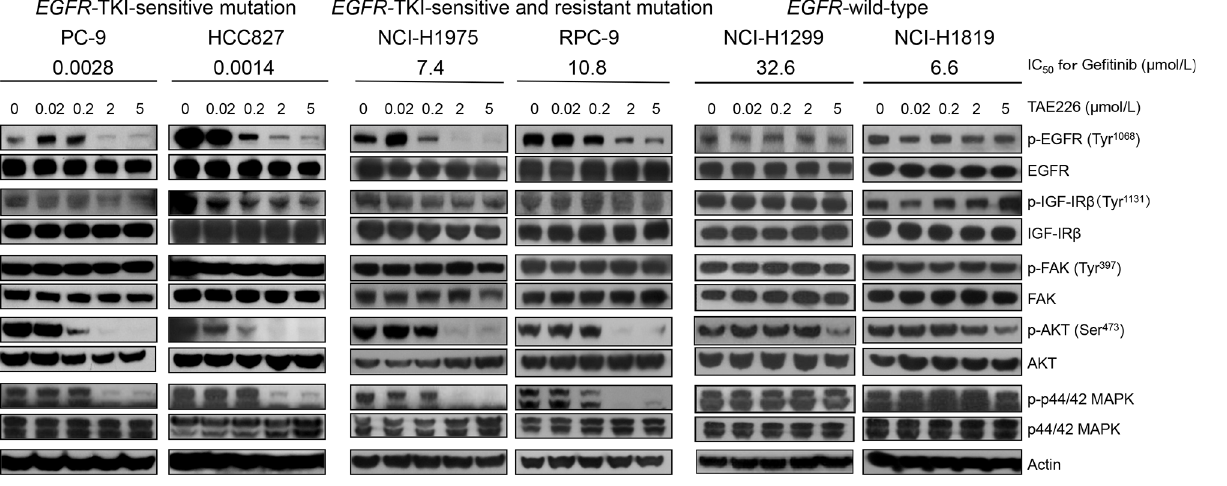
Fig 1. The effects of TAE226 on EGFR-related pathways in NSCLC cell lines. The NSCLC cell lines with EGFR-TKI-sensitive (exon 19 deletions) mutation (PC-9 and HCC827), cell lines with both EGFR-TKI-sensitive and-resistant (T790M) mutations (NCI-H1975 and RPC-9), and cell lines with wild- type EGFR (NCI-H1299 and NCI-H1819) were treated with TAE226 at several concentrations and western blotting analysis was performed. The phosphorylations of FAK and IGF-IR were not suppressed in all NSCLC cell lines tested. In contrast, the phosphorylations of EGFR and its downstream proteins, AKT and MAPK, were suppressed at lower concentration of TAE226 in EGFR -mutant cell lines regardless of the presence of T790M mutation compared with EGFR -wild-type cell lines. We incubated the membrane for Actin (42 KDa) after we incubated MAPK (42 and 44 KDa) and the stripping buffer was used for that